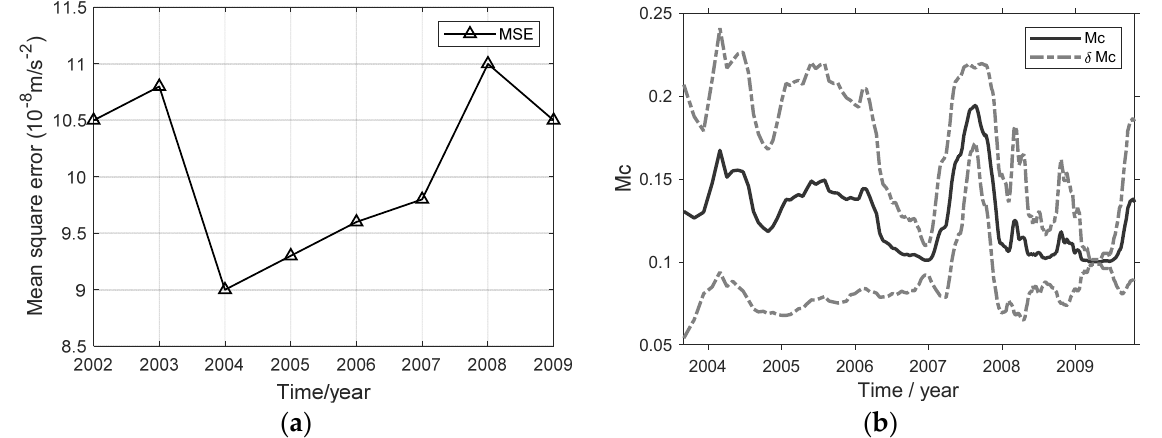
Figure 3. Data accuracy and integrity: ( a ) Mean-squared error of the gravity observation network from 2002 to 2009. ( b ) Magnitude of completeness calculated by using Zmap.